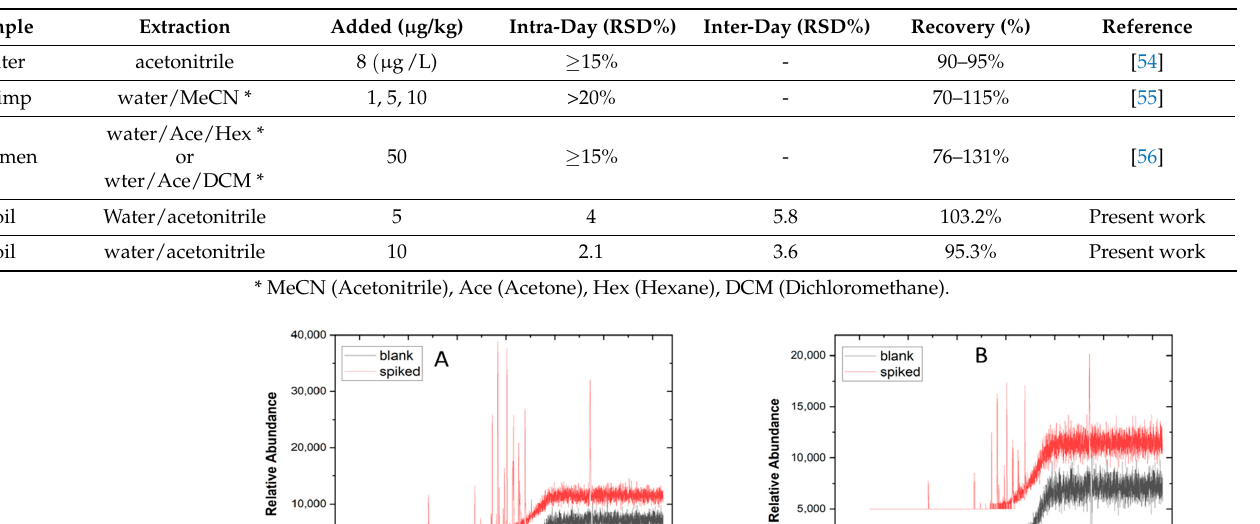
Table 1. Comparison of the present study with other studies. For the present work recovery and RSD was included at different Aroclor 1254 concentrations in soil samples (n = 3).